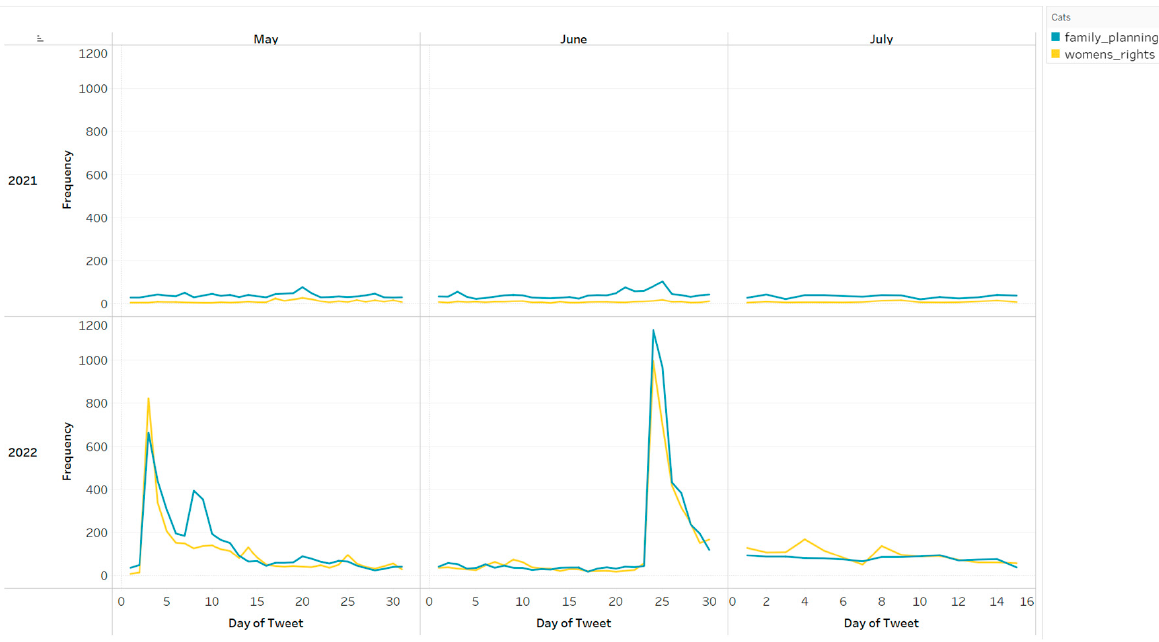
Figure A5. Number of tweets about Women’s Rights and Family Planning across 1 May–15 July 2021 and 2022.